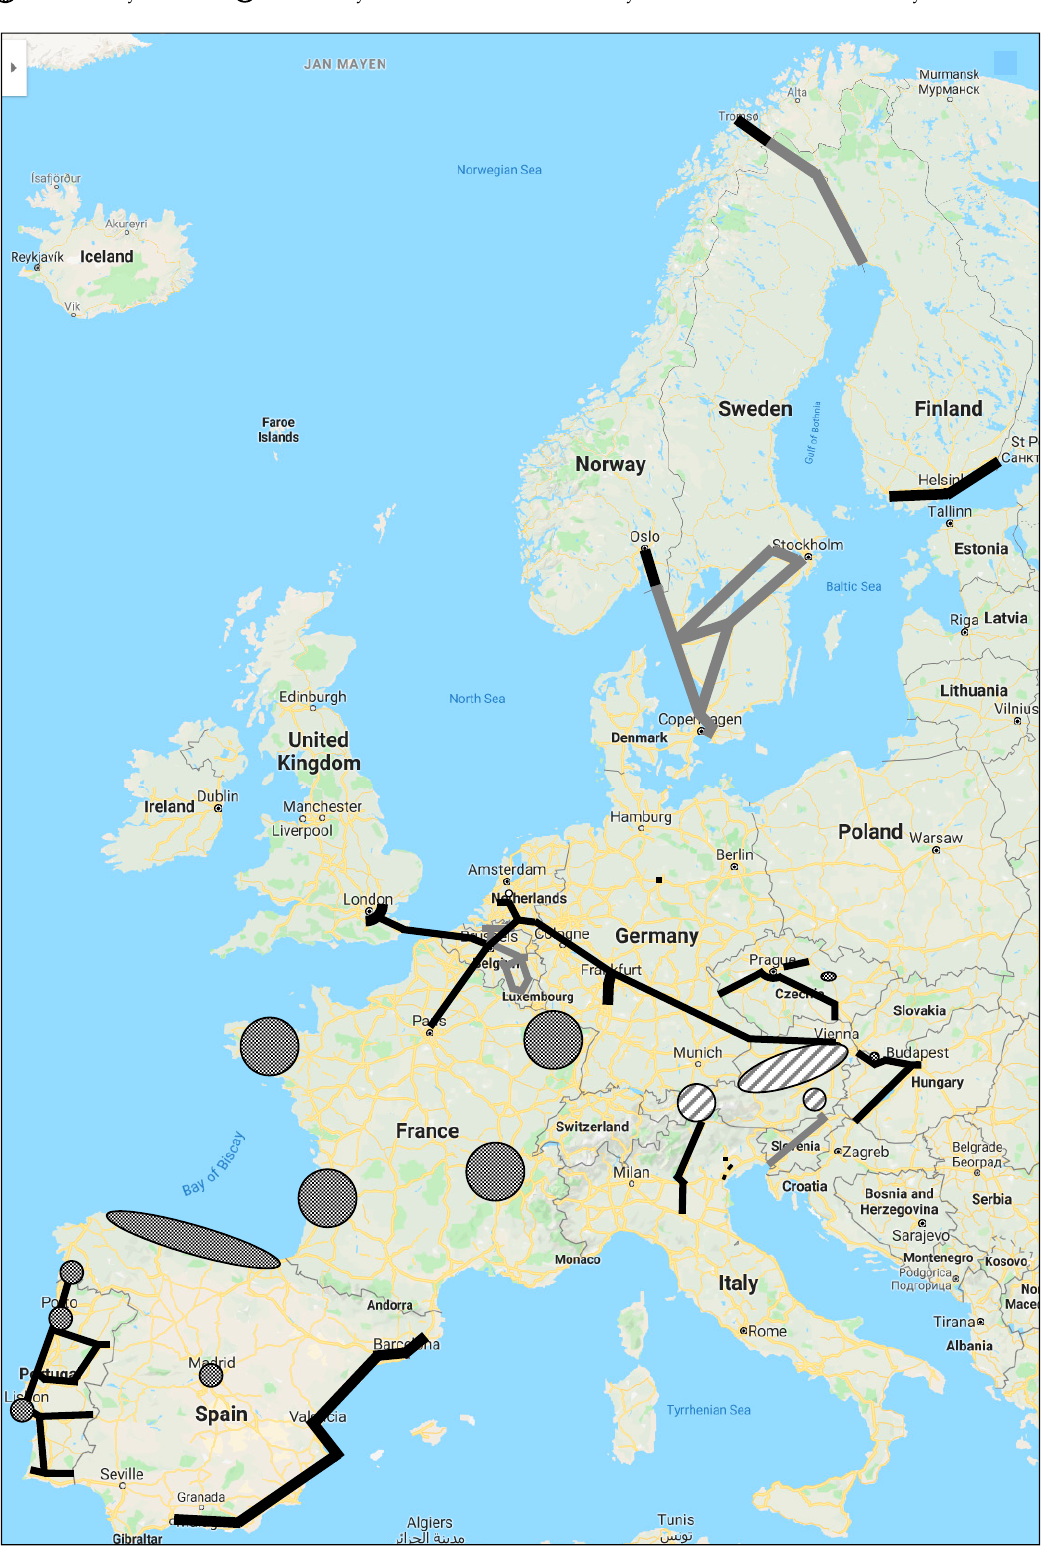
Figure 2. Synoptic view of C-ITS deployment activities across the